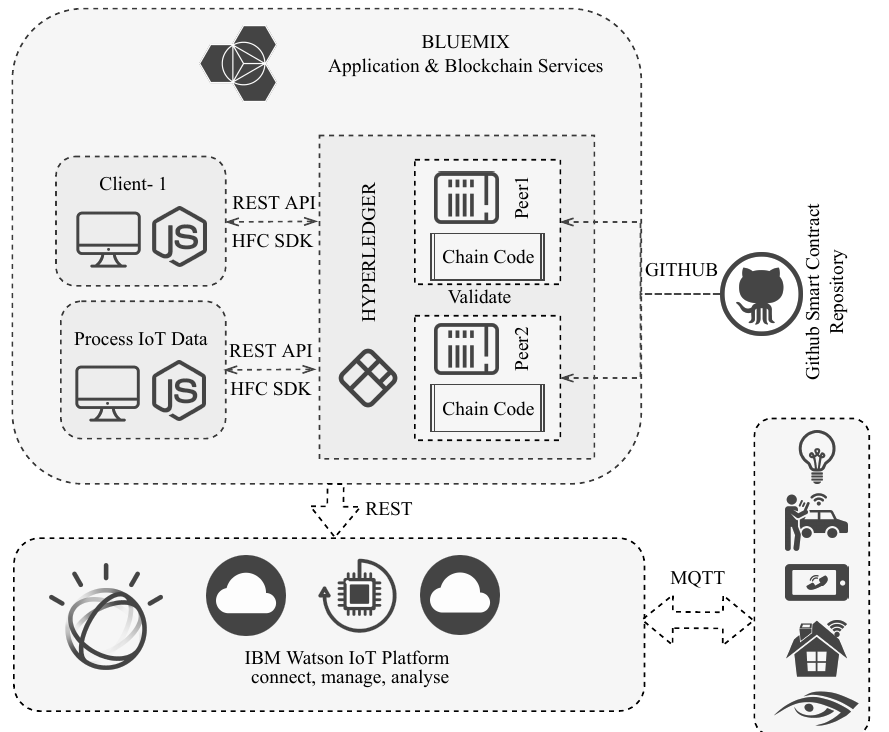
Figure 5. IBM Watson and Bluemix have been integrated with the IoT-BC service. Using Bluemix’s BC network, Watson can communicate with IoT devices via Github’s smart contact